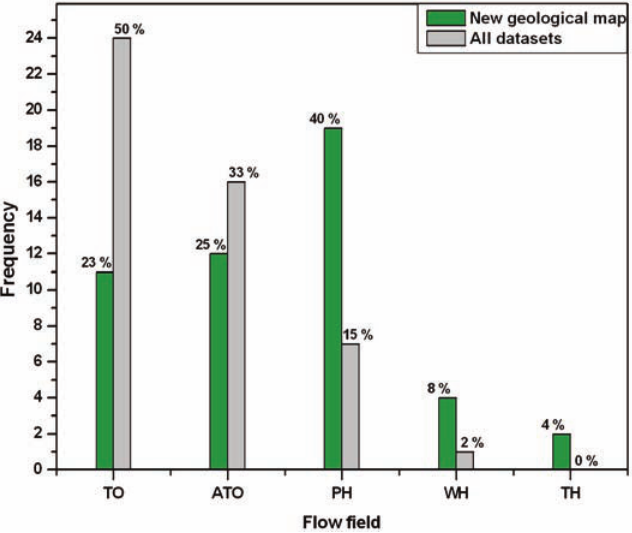
Figure 3. Classification of the lava flow fields over the last 400 year as: to- tally or almost totally outcropping (TO or ATO), and partially, widely or totally hidden (PH, WH or TH). Green bars refer to the flows defined only on the NGM, while gray bars refer to all of the datasets. The percentages associated with each group are given above the corresponding